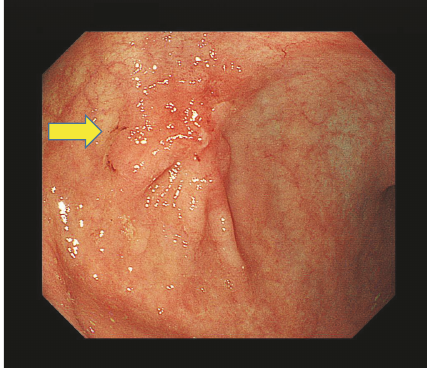
Figure 6: Esophagogastroduodenoscopy showed that the patient’s gastric cancer (arrow) was reduced on the 273rd